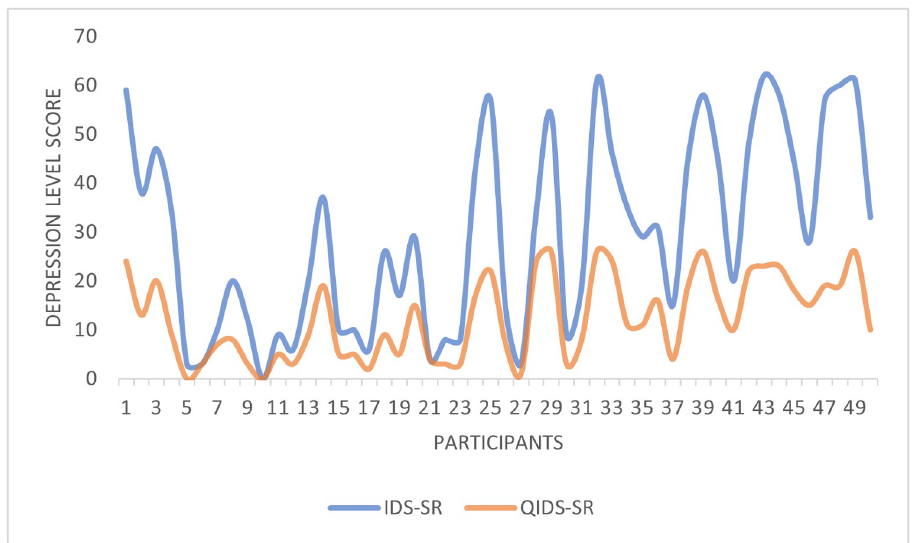
Fig 8. Scoring system comparison against IDS-SR and